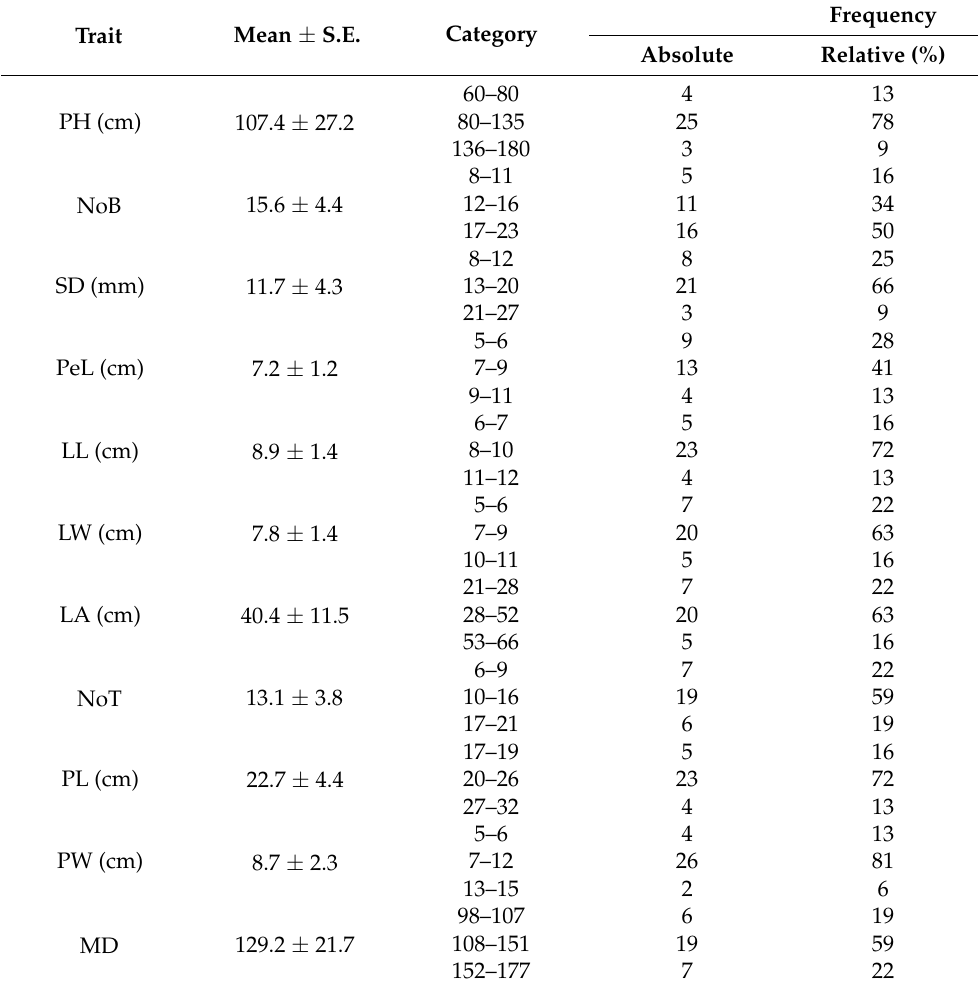
Table 3. Mean ± standard error (S.E.) and frequency distribution for each quantitative trait of the tested quinoa